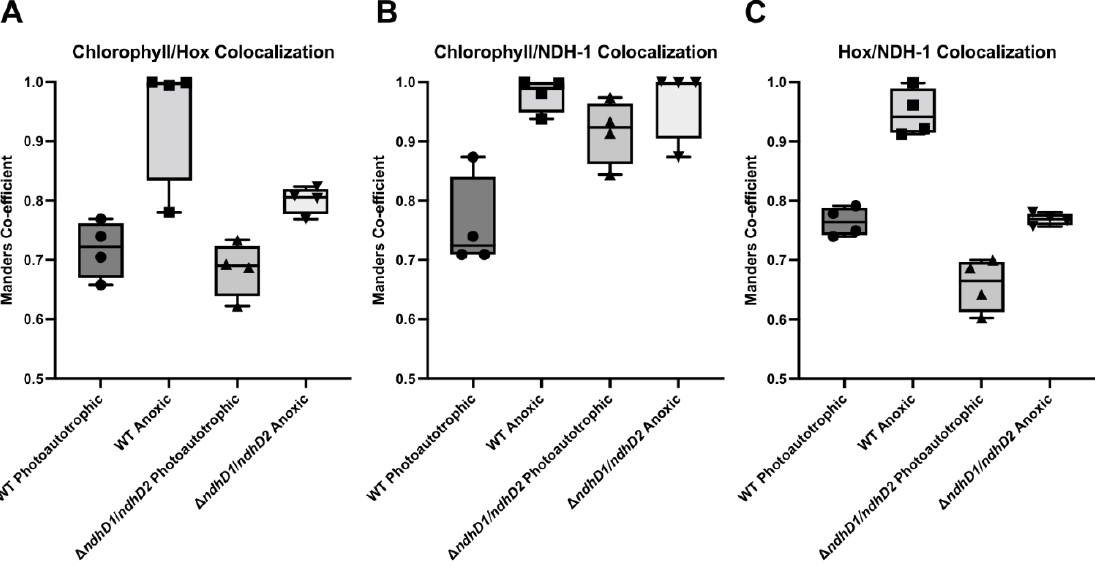
Figure 8. Spatial analysis of Hox, NDH-1 and chlorophyll distribution in cells grown photoautotrophically at 30 µmole photons m −2 s −1 and following anoxia. The distribution of Hox relative to photosynthetic pigment ( A ), The distribution of NDH-1 relative to photosynthetic pigment ( B ), and the distribution of Hox relative to NDH-1 ( C ). Box plot displays the minimum and maximum Manders coefficient values with individual data points. Data represent four biological replicates: WT photoautotrophic n = 898, WT anoxic n = 1010, ∆ ndhD1 ∆ ndhD2 photoautotrophic n = 912, ∆ ndhD1 ∆ ndhD2 anoxic n =